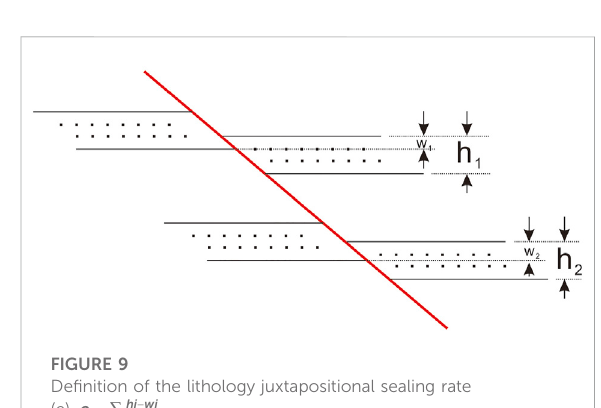
FIGURE 9 De fi nition of the lithology juxtapositional sealing rate (e). e (cid:1) (cid:1) hi − wi hi .